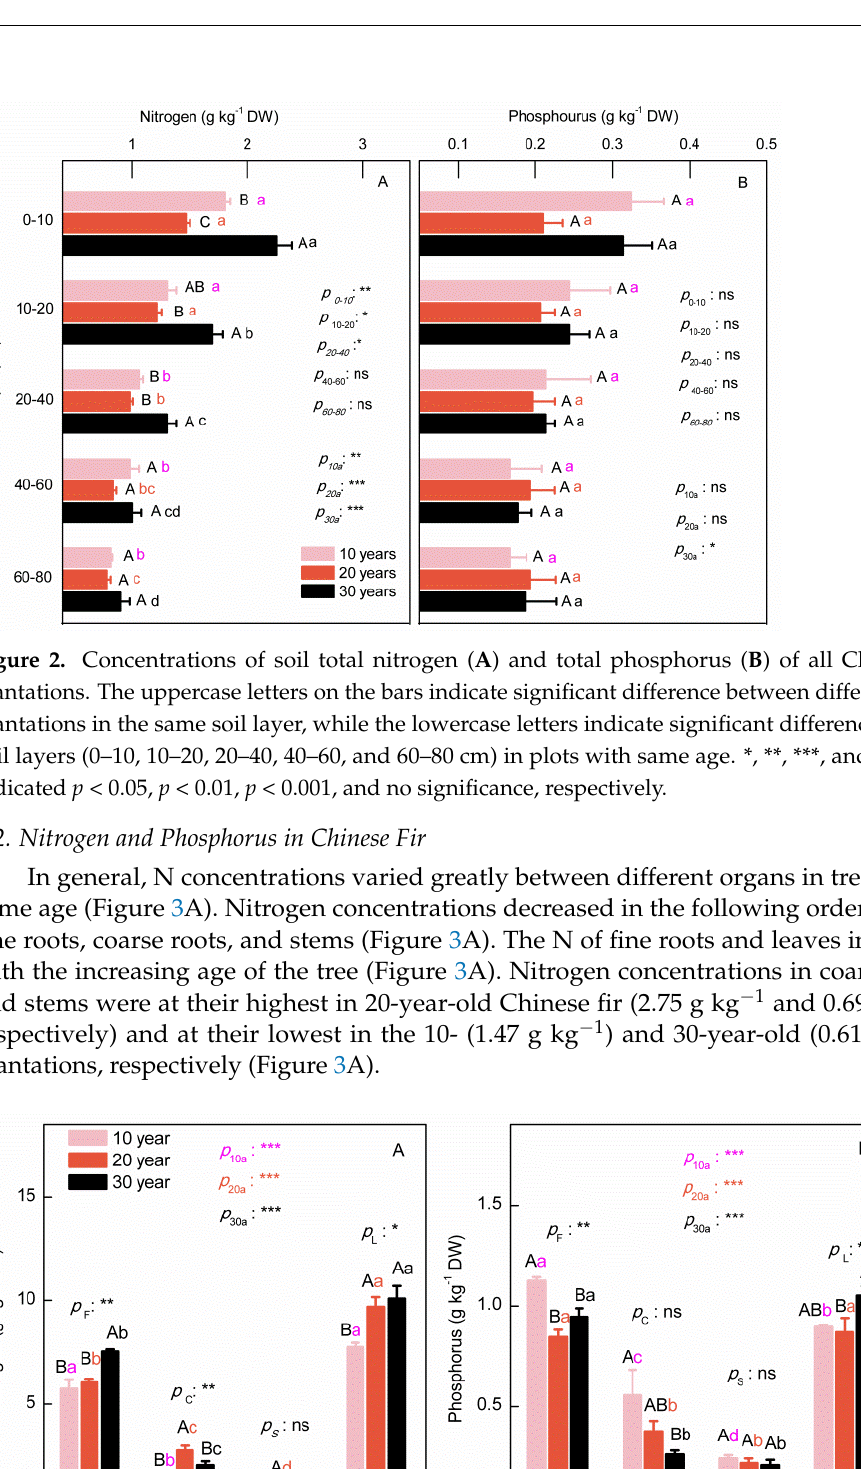
Figure 3. Concentrations of total nitrogen ( A ) and phosphorus ( B ) in fine roots (F roots), coarse roots (C roots), stems, and leaves of all Chinese fir. The uppercase letters on the bars indicate significant difference between different aged trees of the same organs, while the lowercase letters indicate significant difference among organs in trees with same age. *, **, ***, and ns were indicated p < 0.05, p < 0.01, p < 0.001, and no significance, respectively.